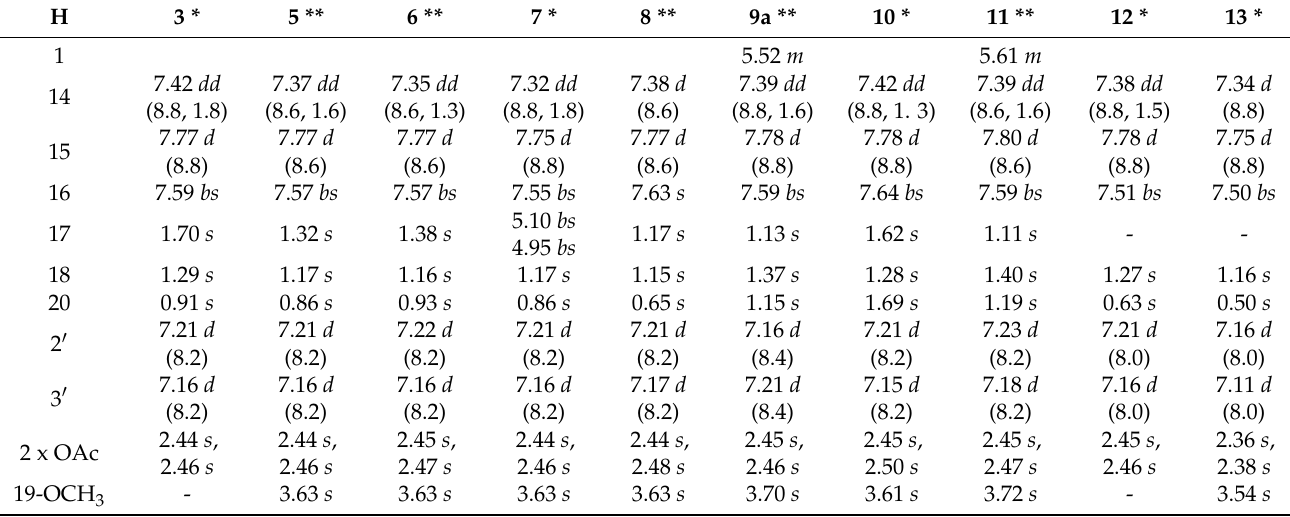
Table 2. 1 H-NMR data for compounds 3,5–13 ( δ ppm ( J in